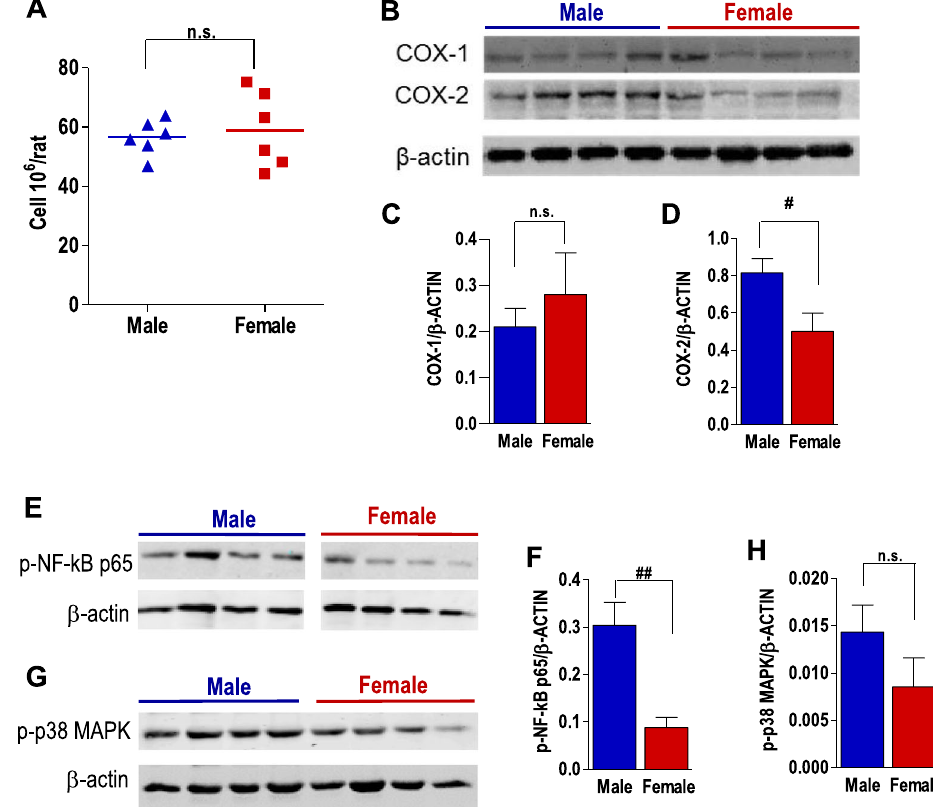
Figure 3. Cyclooxygenase expression and NF- κ B activation in thoracic exudates differ between male and female cells. Rats were treated with carrageenan (intra thoracic injection) and sacrificed after 4 hrs. ( A ) Numbers of infiltrated cells (10 6 /rat) were measured in a Burker chamber using light microscopy. ( B ) Analysis of COX-1/2, ( E ) phospho-NF- κ B p65 and ( G ) phospho-p38 MAPK by Western blot in total cell lysates of thoracic exudates from male and female carrageenan-treated rats. Densitometric analysis of ( C ) COX-1, ( D ) COX-2, ( F ) phospho-NF- κ B p65 and ( H ) phospho-p38 MAPK protein normalized to β -actin expression. Values represents means ± S.E.M., n = 4 rats. # p < 0.05; ## p < 0.01, male vs female; two-tailed Student’s t